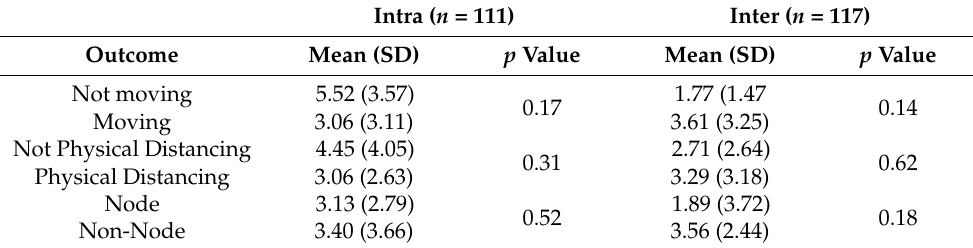
Table 4. Latitude and longitude coordinate